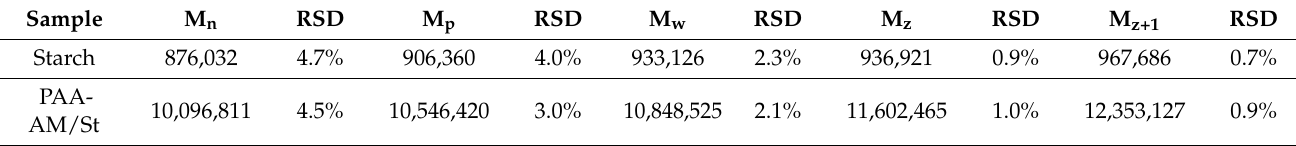
Figure 2. The molecular weight and the molecular weight distribution of PAA-AM/St. Table 1. Different average molecular weights of starch and